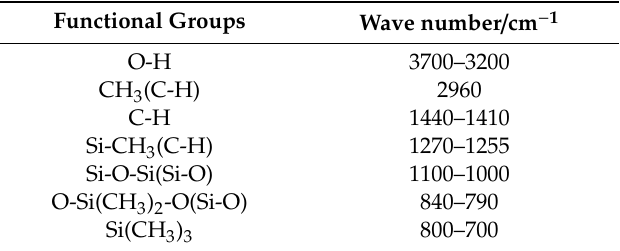
Table 4. Key absorption peaks of silicone rubber in Fourier transform infrared spectroscopy (FTIR) analysis.